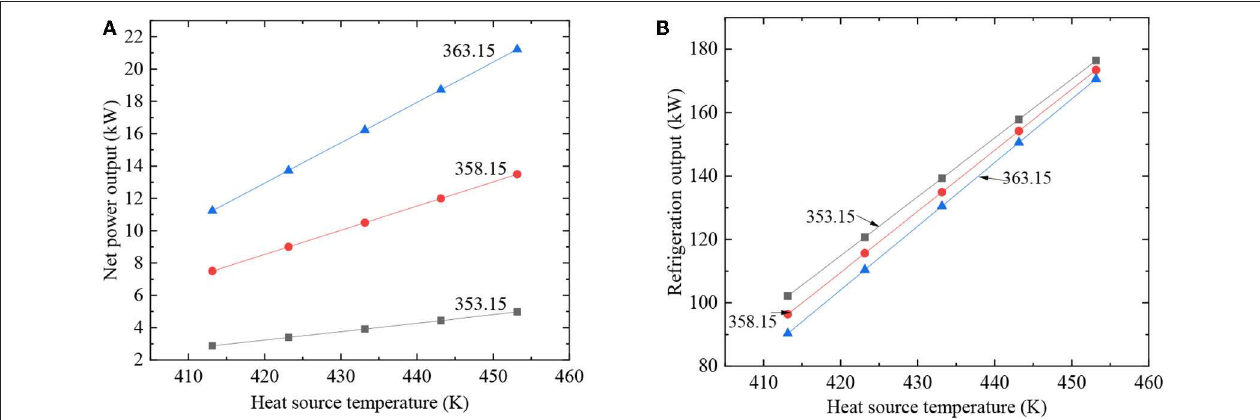
Frontiers in Energy Research |